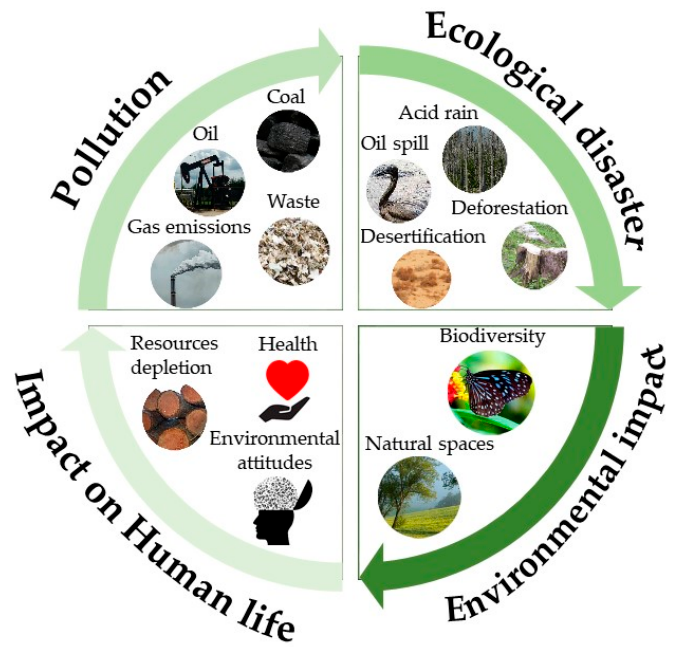
Figure 1. Cycle of the impact of the human being on nature.